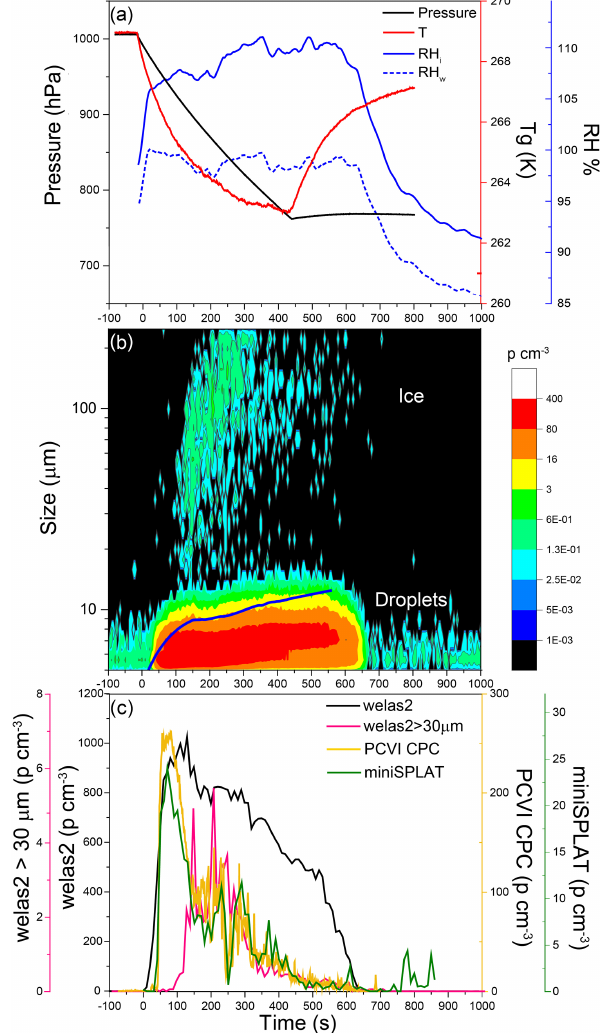
Figure 9. Data from Expansion 2 with PF CGina bacteria. (a) The pressure (black) and the temperature of the gas (red) inside the AIDA chamber. The measured RH with respect to ice (RH i ) and water (RH w ) is indicated in solid and dashed blue lines, respec- tively; (b) the size distributions of the particles measured with we- las2 during the expansion. Particles smaller than ∼ 15µm are liquid droplets, while larger particles are ice. The PCVI cut size is shown by the blue trace. (c) The welas2-measured total particle number concentrations (black) and the number concentrations of particles larger than 30µm (pink). The number concentrations of particles transmitted by the PCVI and measured by CPC and miniSPLAT are marked in yellow and green,